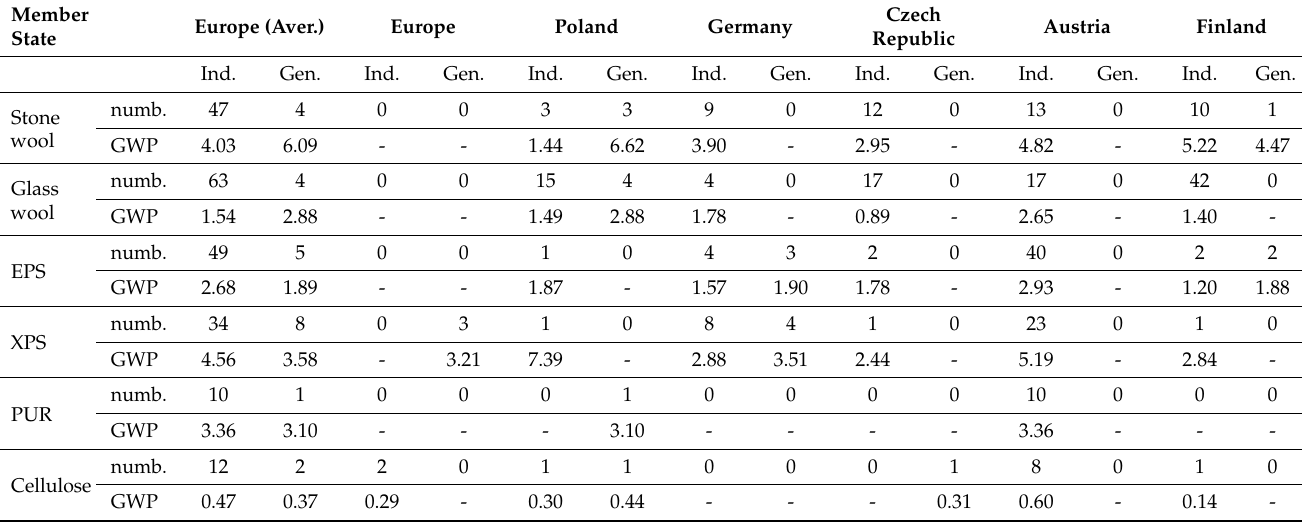
Value of GWP (embodied carbon) for insulation materials (ind.—individual